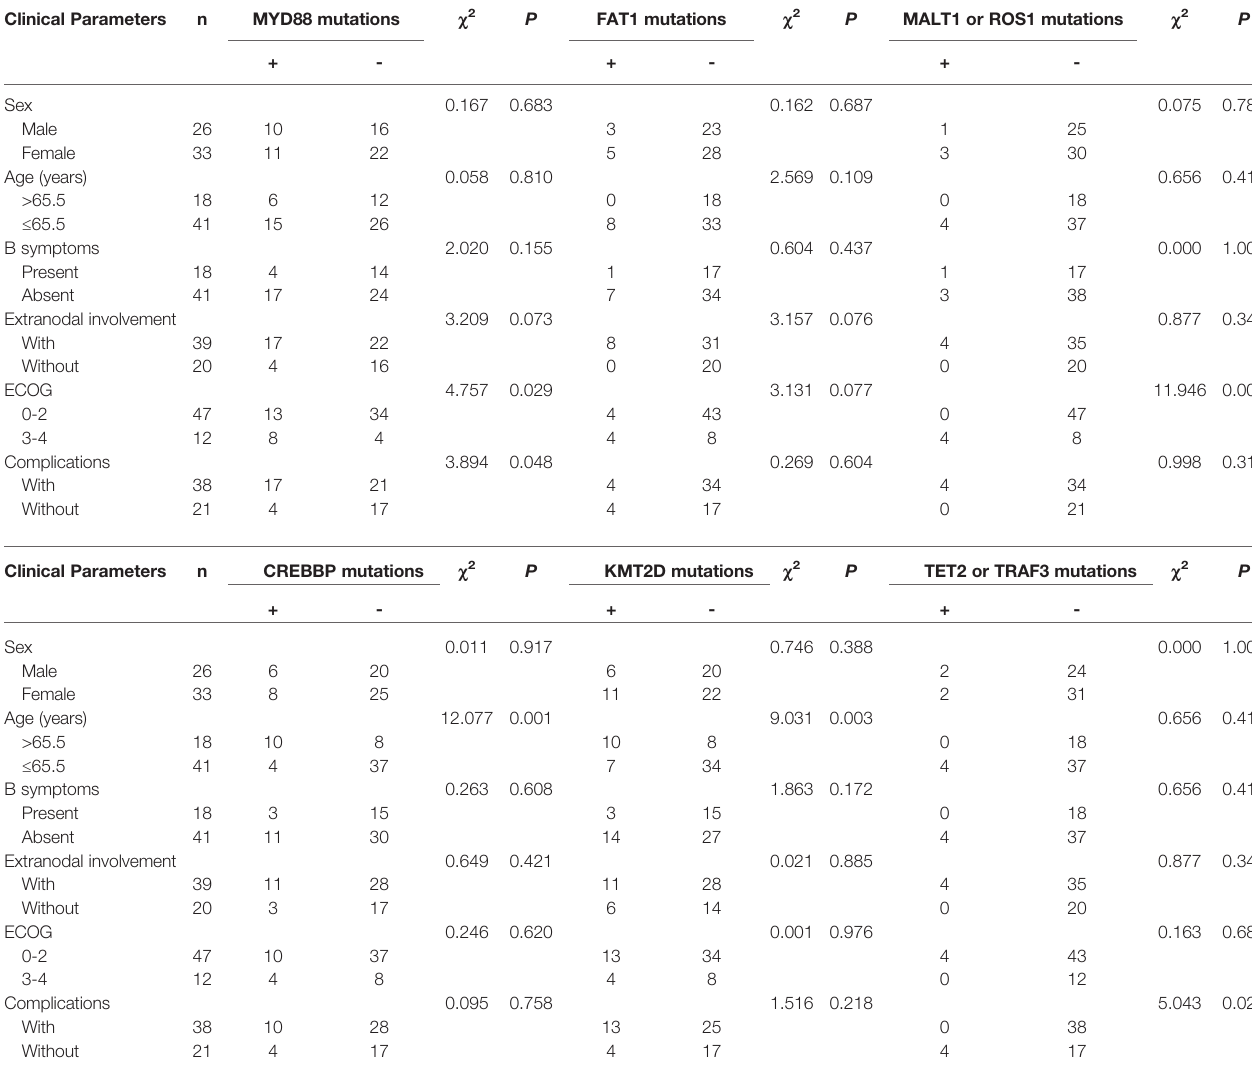
TABLE 3 | Correlation of MYD88, FAT1, MALT1, ROS1, CREBBP, KMT2D, MALT1 and ROS1 mutations with clinical parameters of lymphoma patients. Clinical